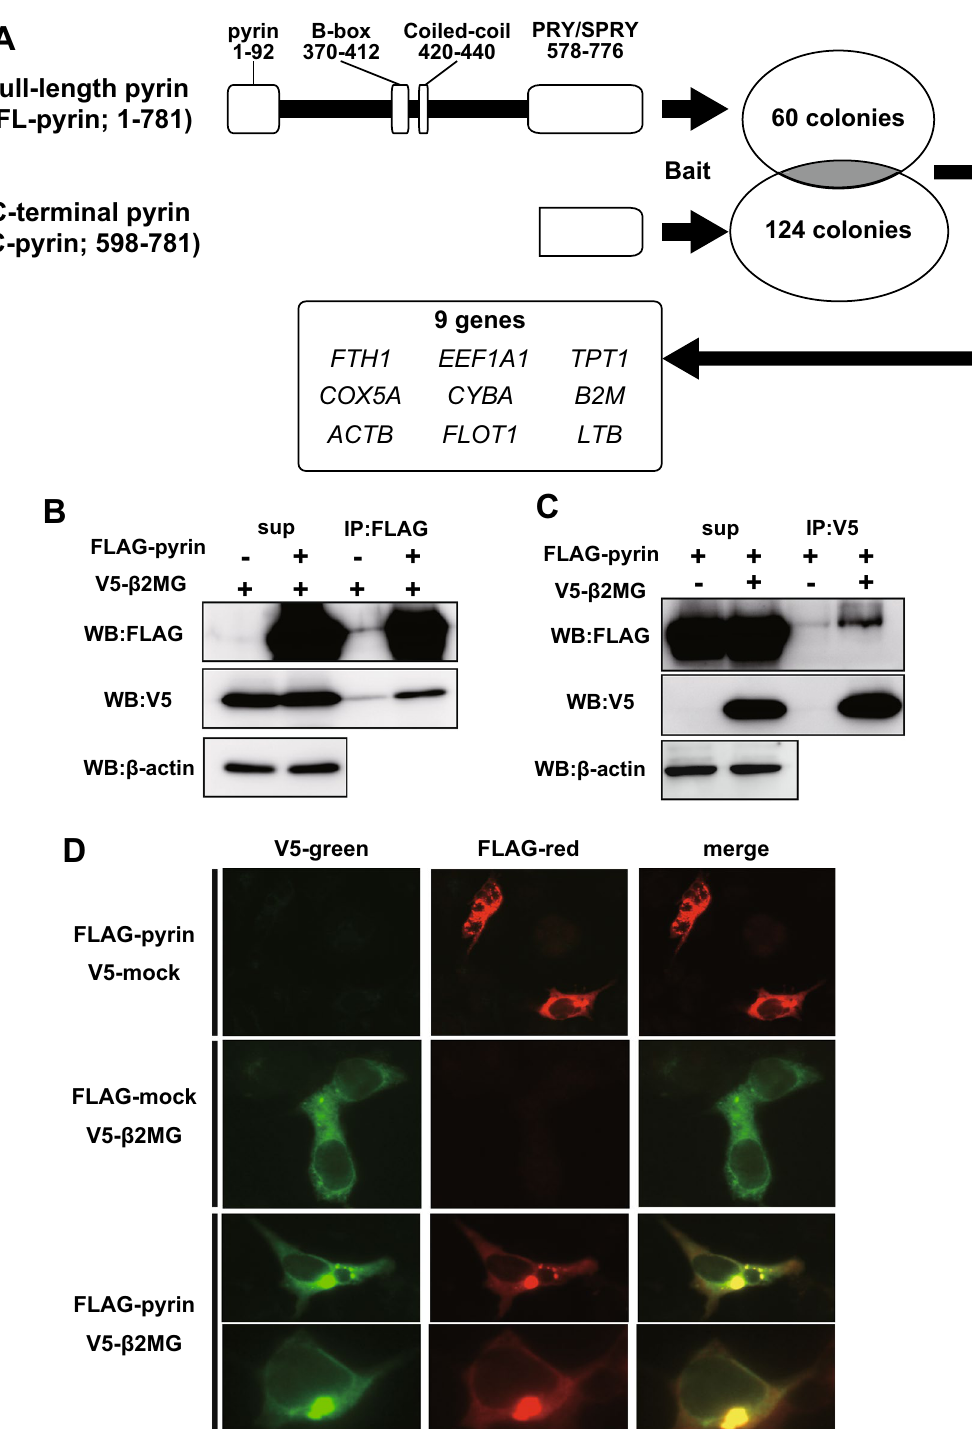
Figure 1. Pyrin interacts with β2MG in mammalian cells. ( A ) The yeast AH109 was transformed with Full- length pyrin (FL-pyrin) or C-terminal pyrin (C-pyrin) inserted in pGBKT7 vector as baits. As prey, human leukocyte cDNAs were inserted in pACT2 and transfected to yeast Y187 strain. After mating, FL-pyrin and C-pyrin baits yielded 60 and 124 positive colonies, respectively. Nine common genes were identified from both FL- and C-pyrin baits. ( B , C ) Lenti-X 293T cells expressing FLAG-tagged pyrin (FLAG-pyrin) and V5-tagged β2MG (V5-β2MG) were lysed and immunoprecipitated by FLAG Ab-conjugated agarose beads or V5 Ab-conjugated magnet beads, and then subjected to immunoblot analysis. V5-β2MG is co-immunoprecipitated with FLAG-pyrin ( A ) and vice versa ( B ). ( D ) HEK293 cells expressing FLAG-pyrin (red) and V5-β2MG (green) were subjected to immunofluorescence staining. Pyrin and β2MG shows co-localization in the